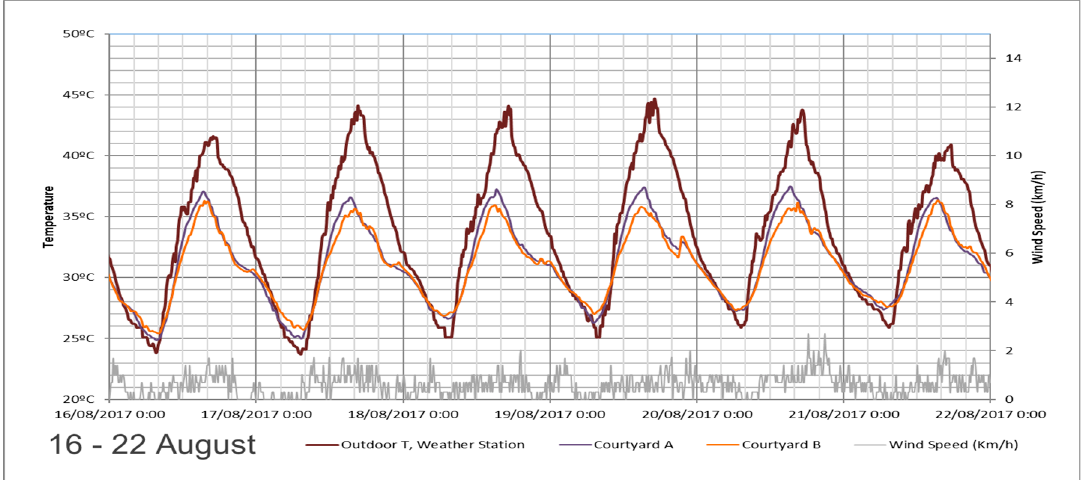
Figure 2. Air temperatures and wind speed in courtyards and the outside from 16 to 22